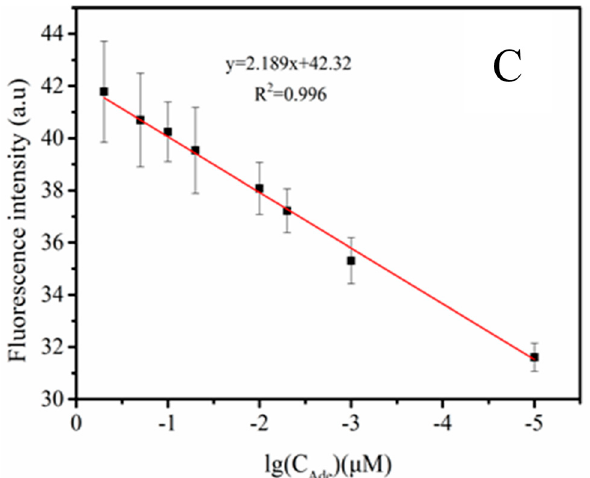
Figure 5. ( A ) Fluorescence emission spectra of the sensing system in the presence of different concentrations of adenosine. From bottom to top: 0, 0.00001, 0.00005, 0.0001, 0.001, 0.005, 0.01, 0.05, and 0.1 µ M. ( B ) The relationship between fluorescence intensity and the concentration of adenosine. ( C ) A linearity curve (R2 = 0.996) was confirmed as the logarithm of adenosine concentration changed from 10 pM to 0.5 µ M. The error bars are standard deviations of three repetitive measurements.